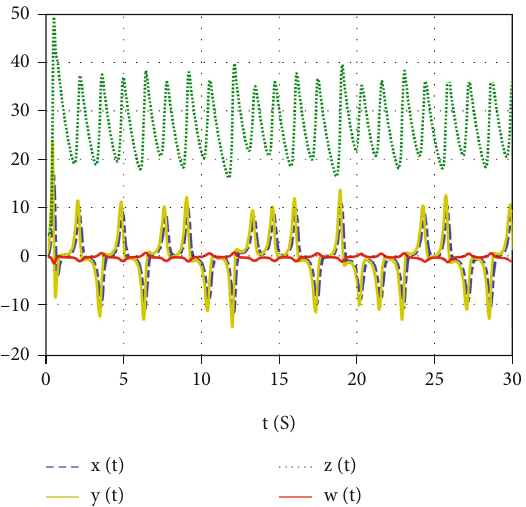
Figure 5: Time series trajectories of system (5) for the fractional order η = 0 : 974 :